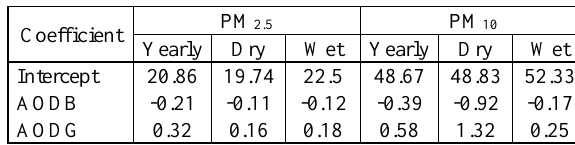
Table 2. Coefficient values of the generated PM models using